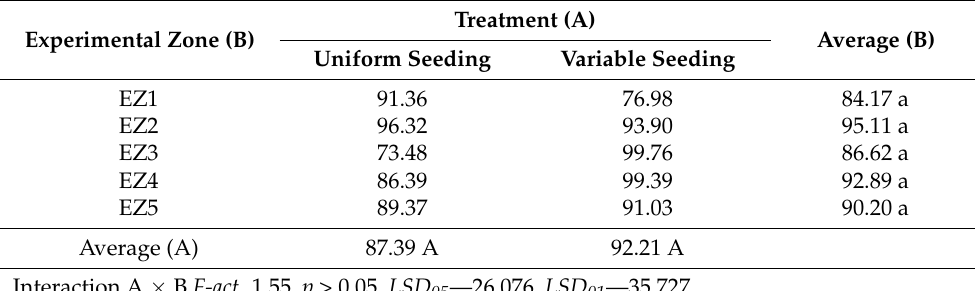
Table 6. Winter wheat seed germination for different zones and seeding treatments of experiment (%).